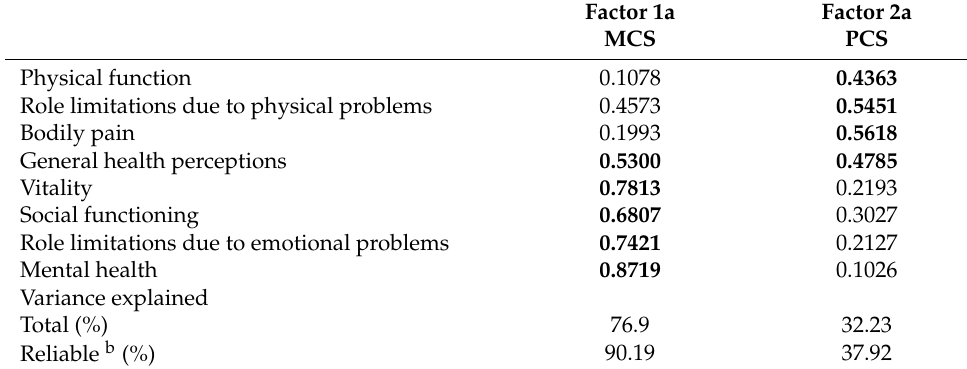
Table A1. Factor analysis SF-36 for Chilean teachers. Rotated factor loadings and variance explained.